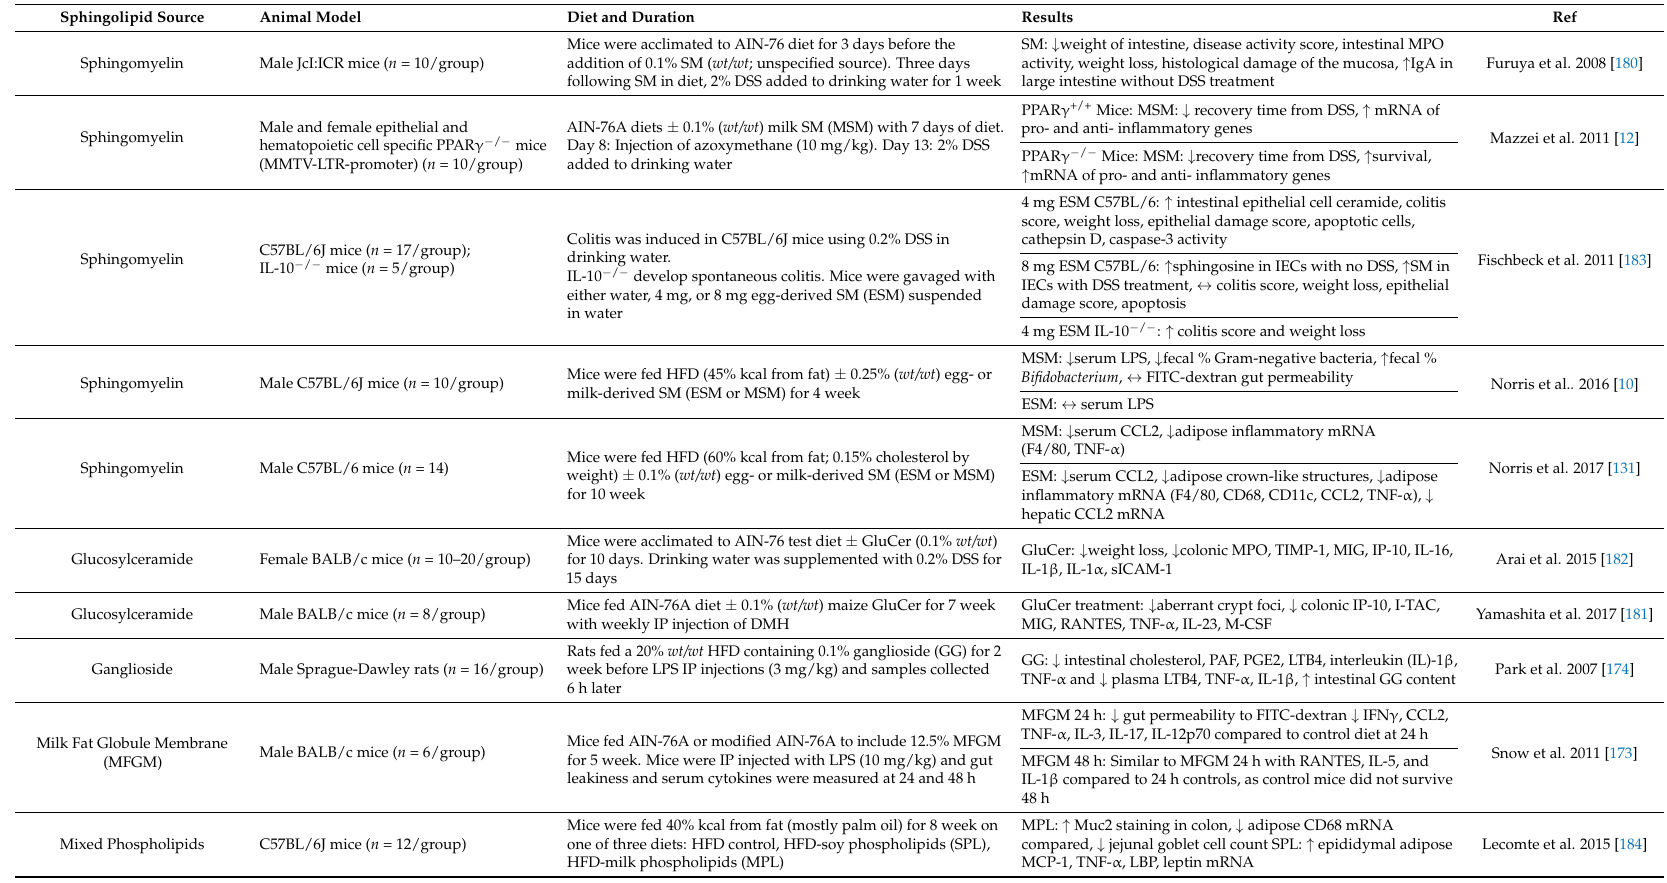
Table 2. Animal studies examining the effects of dietary sphingolipids on